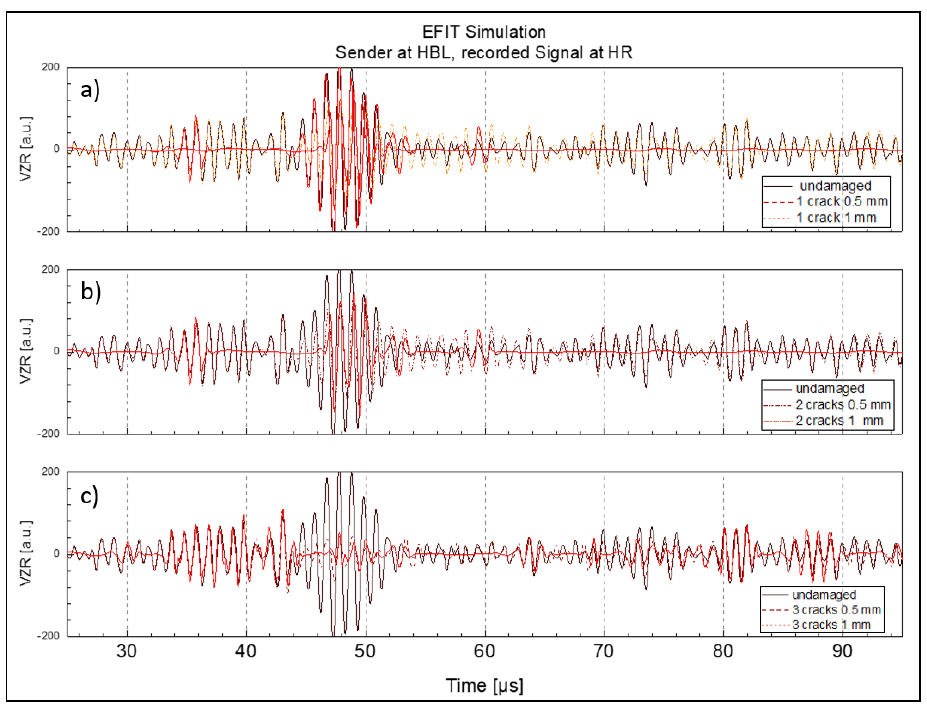
Figure 11. Change of transmitted R-wave received at position HR with increasing number of cracks and crack depths up to 1 mm; ( a ) 1 crack ( b ) 2 cracks ( c ) 3 cracks.